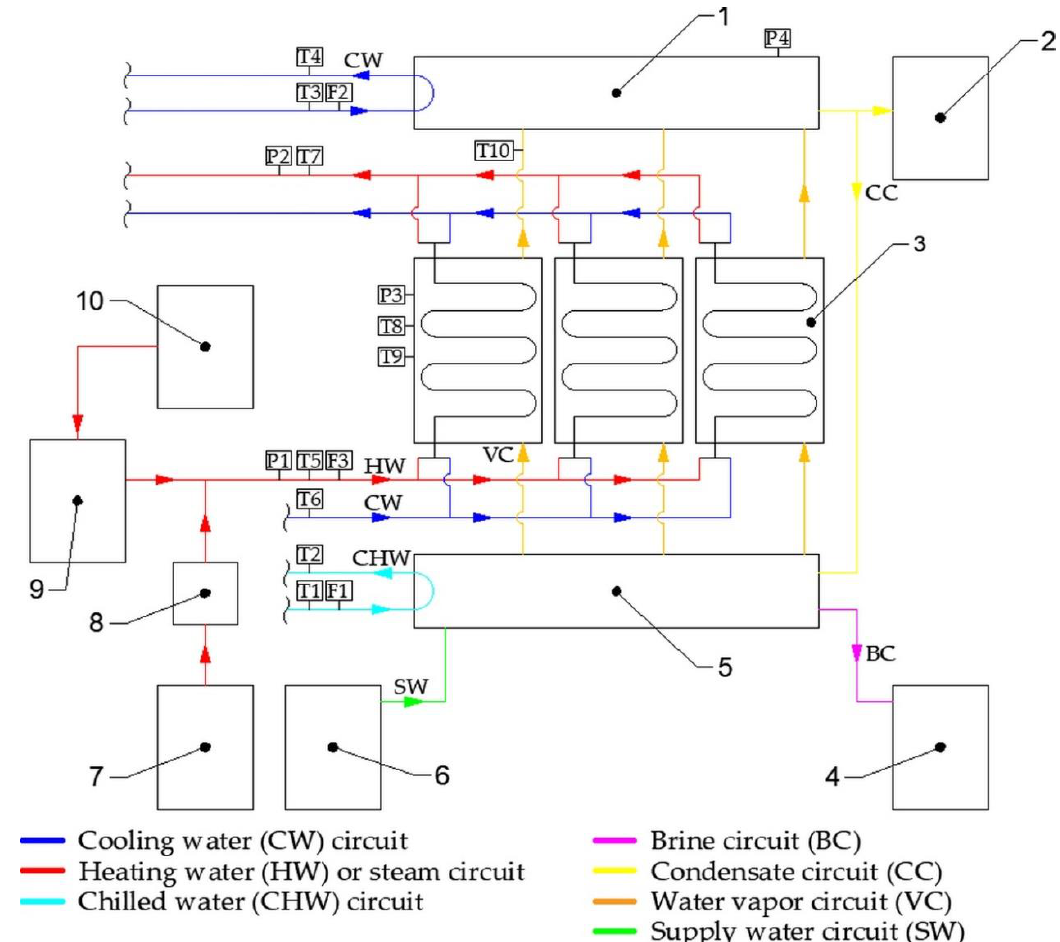
Figure 1. Simplified diagram of the test stand. 1—condenser; 2—distillate tank; 3—adsorption bed; 4—brine tank; 5—evaporator; 6—degasification tank; 7—steam generator; 8—manifold; 9—hot water tank; 10—electric heater; T1—chilled